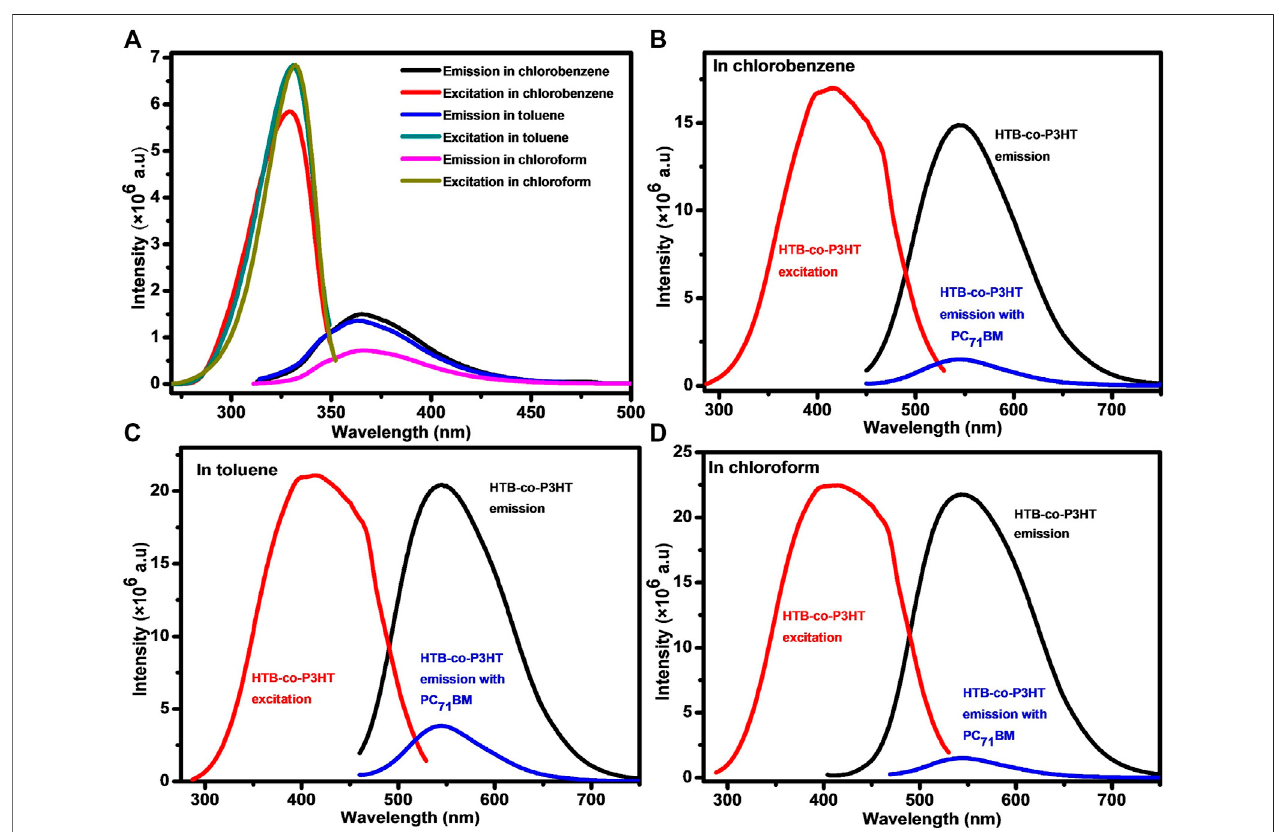
FIGURE 8 | (A) Photoluminescence spectra of HTB in different solvents. Photoluminescence spectra of HTB-co-P3HT in (B) chlorobenzene, (C) toluene and (D) chloroform.